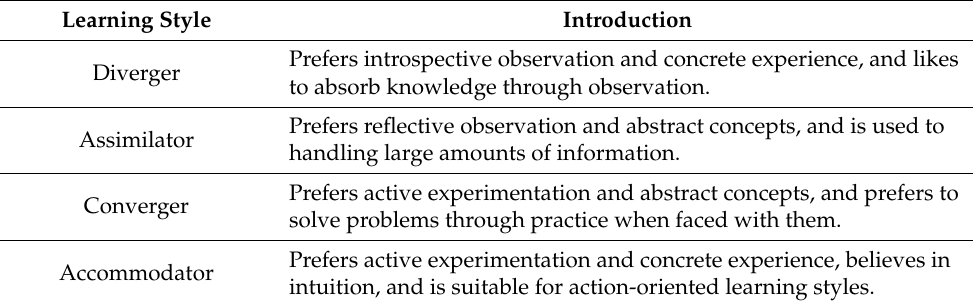
Table 1. Introduction to Kolb learning styles